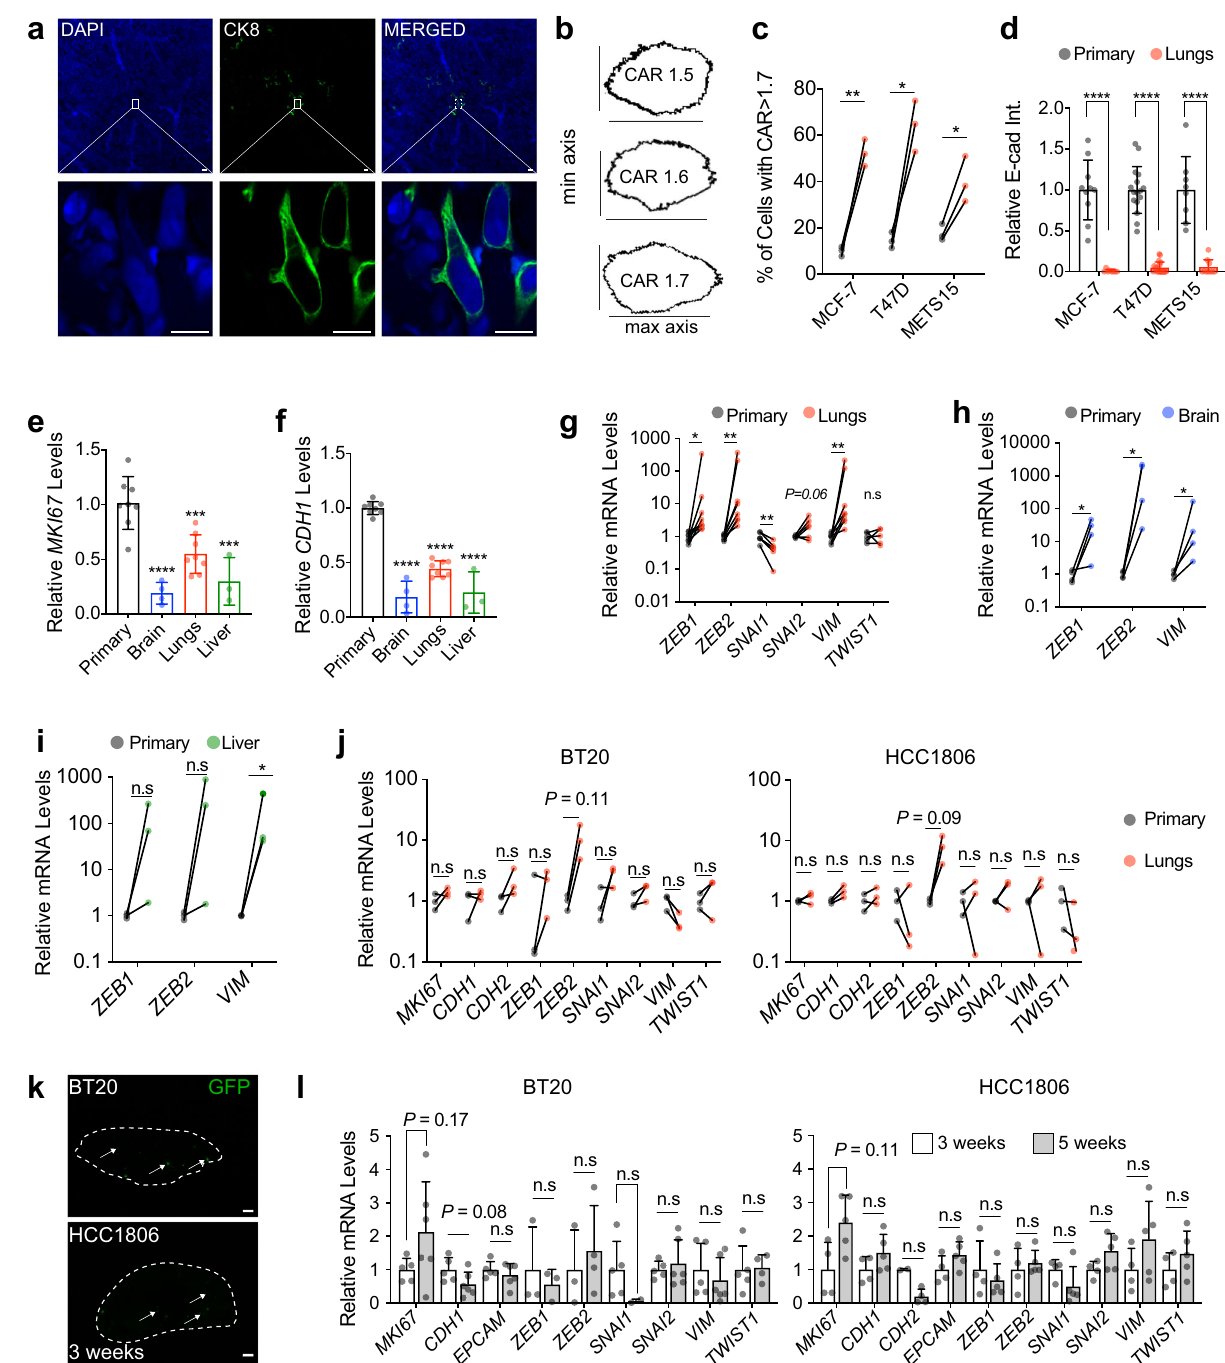
Fig.3|DormantDTCsfromER + intraductalxenograftshaveanEMPsignature. a CK8 staining on optically-cleared sections of METS15 cells in host ’ s lungs. Scale bars, 10 µ m. b Representative masks representing different cellular aspect-ratio (CAR) with respect to the morphology c Percentage of cells with CAR>1.7 in matched primary tumors and in the lung from intraductal ER + BC xenografts- bearing mice. Data represent mean±SD, each data point represents at least 100 primarycellsand10lungDTCsfrom3mice.PairedStudent ’ s t -test. d RelativeE-cad intensity (Int.) in matched primary tumor cells and lung DTCs in mice bearing indicated intraductal xenografts. Data represent n ≥ 8 images, mean±SD from 3 mice.Studentst-test e , f Relative MKI67 ( e )and CDH1 ( f )mRNAlevelsinMCF-7cells in the primary tumor (8 mice) or in the lung ( n =8), brain ( n =4), and liver ( n =3) DTCs. Data represent mean±SD. One-way ANOVA. g – i Relative levels of indicated